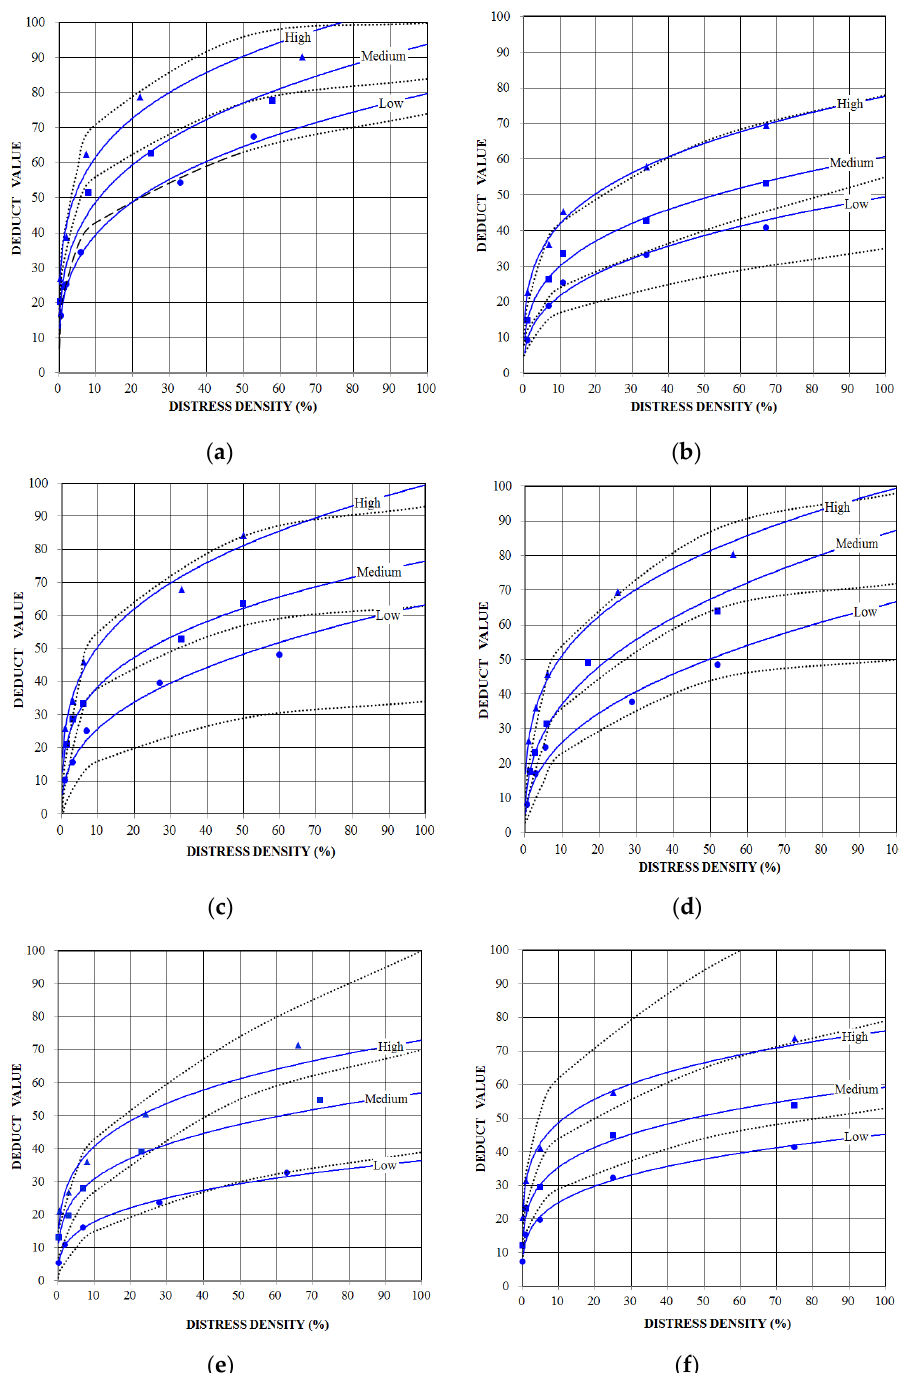
Figure 4. Comparisons between developed deduct value curves and ASTM D 5360 in asphalt pavement; ( a ) Alligator cracking, ( b ) block cracking, ( c ) reflection cracking, ( d ) longitudinal and transverse cracking, ( e ) patching and utility cut patching, ( f ) rutting.